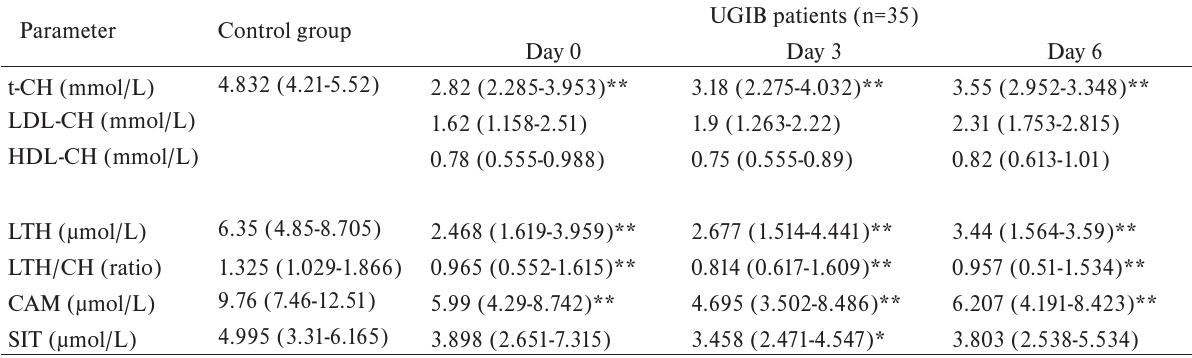
Table 2. Plasma concentration of lipids and sterol in patients with UGIB (n=35). Comparison with control group.